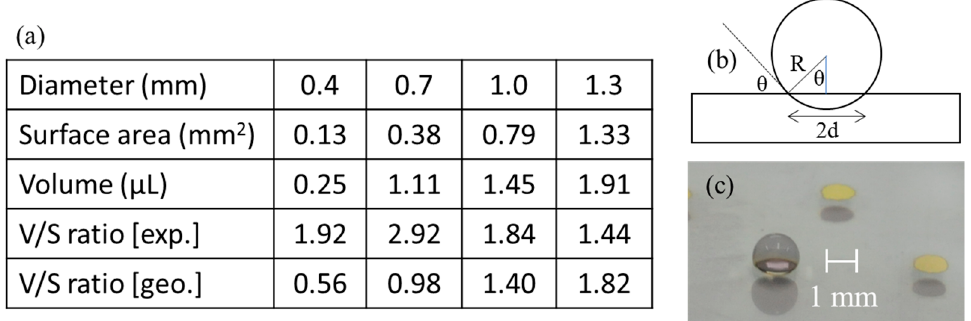
Figure 2. ( a ) Table showing surface-enhanced Raman spectroscopy (SERS) spot surface areas, maximum volumes of samples that can be placed, experimentally obtained and geometrically derived sample volume to the spot surface area ratio (volume/surface) for spot diameters of 0.4, 0.7, 1.0 and 1.3 mm with a simple geometric model ( b ). ( c ) Photo showing a 1.5 µL water droplet placed on a 1.0 mm SERS spot.